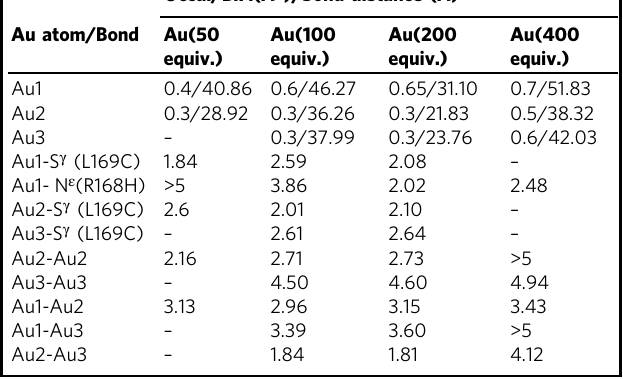
Table 1 B-Factors (B.F.)/occupancies (Occu.), and key bond distances at the 4-fold site of apo-R168H/L169C-rHLFr Au composites with different Au precursor